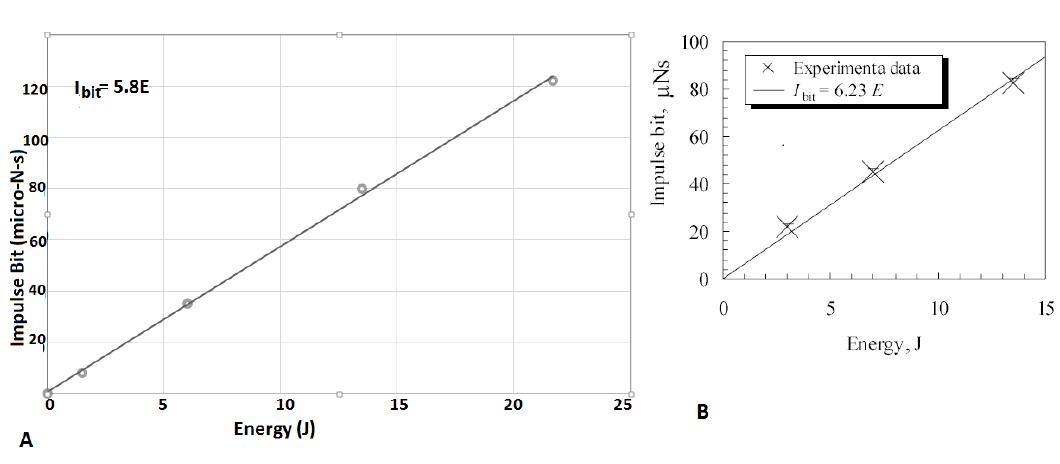
Figure 6. Total impulse bit vs. Discharge energy: ( A ) Simulation result; ( B ) Experimental result [12].